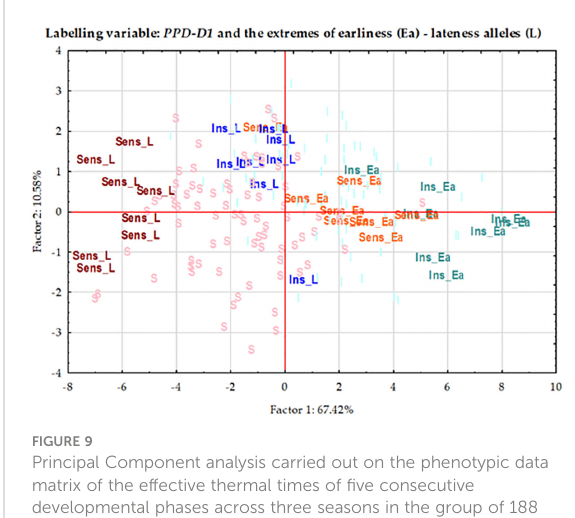
FIGURE 9 Principal Component analysis carried out on the phenotypic data matrix of the effective thermal times of fi ve consecutive developmental phases across three seasons in the group of 188 winter wheat genotypes, where 32 wheat genotypes are highlighted representing the four combinations of PPD-D1 allele phase and the extremity of early vs. late developmental